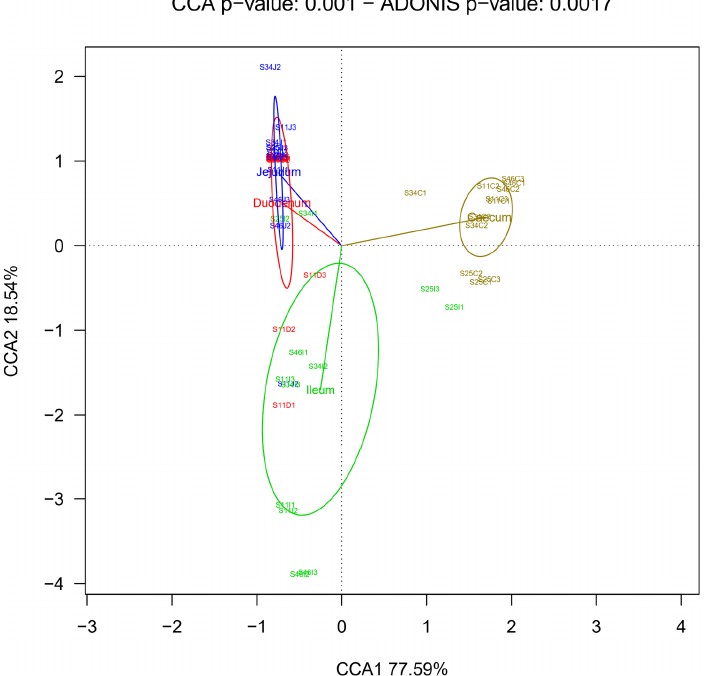
Figure 3. Taxonomic beta diversity analysis by intestine segment. Diversity among samples is shown through canonical correspondence analysis (CCA) plot and Adonis test for significance of chicken gut microbiota at the genus level. The four groups correspond to the duodenum (red), jeju- num (blue), ileum (green), and caecum (brown). The Wilcox test among pairs of tracts also showed that the caecum demonstrated a higher number of statistically significant genus-related differences ( p -value < 0.05) com- pared to other tracts (see Volcano plots, Figure 4).